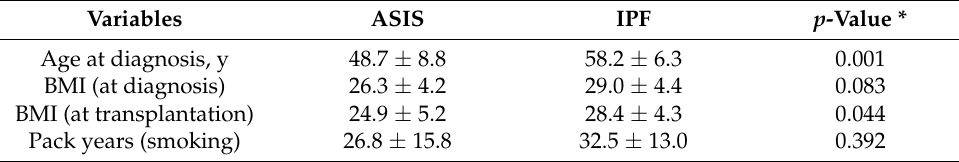
Table 1. Demographic and clinical parameters of the study population (34 patients). Variables ASIS IPF p -Value